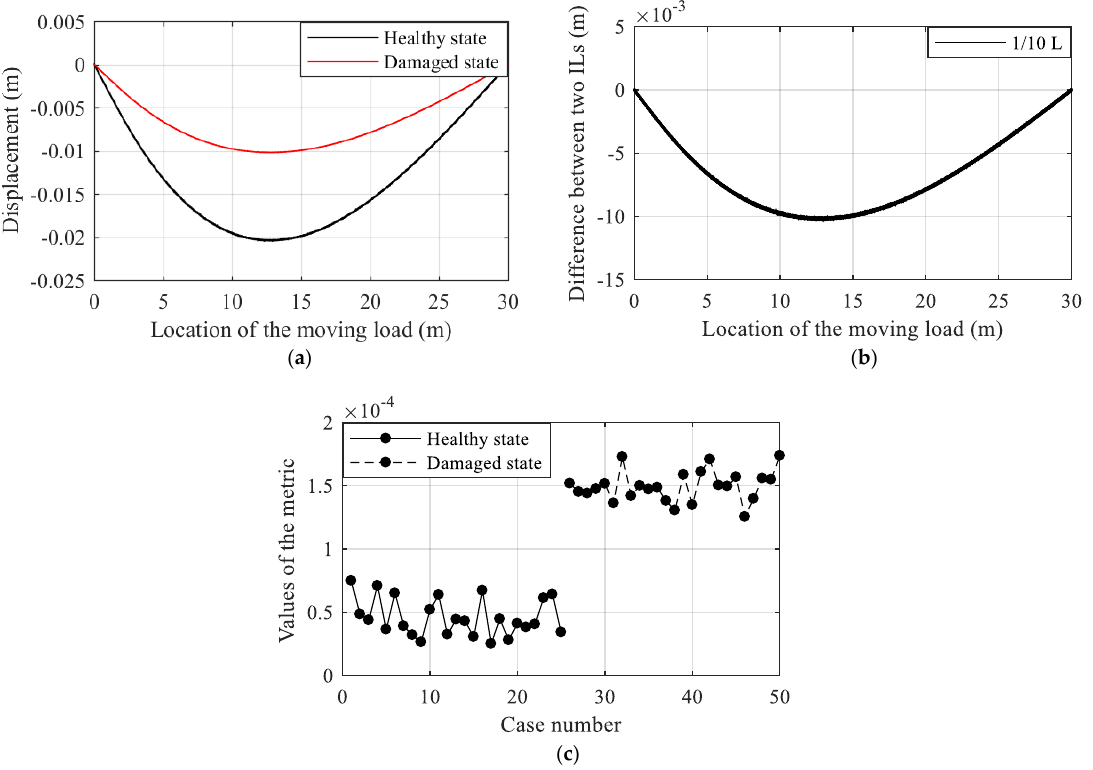
Figure 8. Comparison of the damage detection performance between the traditional method and the proposed method before and after damage with a 1.6% noise level (with vehicle weights of 100 kN and 50 kN before and after damage, respectively): ( a ) displacement ILs; ( b ) difference between two displacement ILs obtained by the traditional method; ( c ) metric of the damage feature obtained by the proposed method.